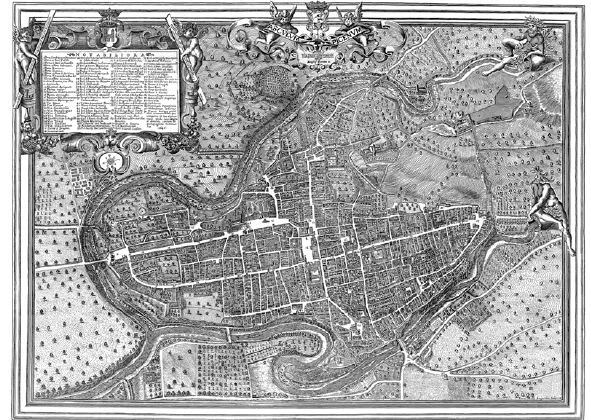
Figure 1. Plant of Ascoli Piceno, Emidio Ferretti,